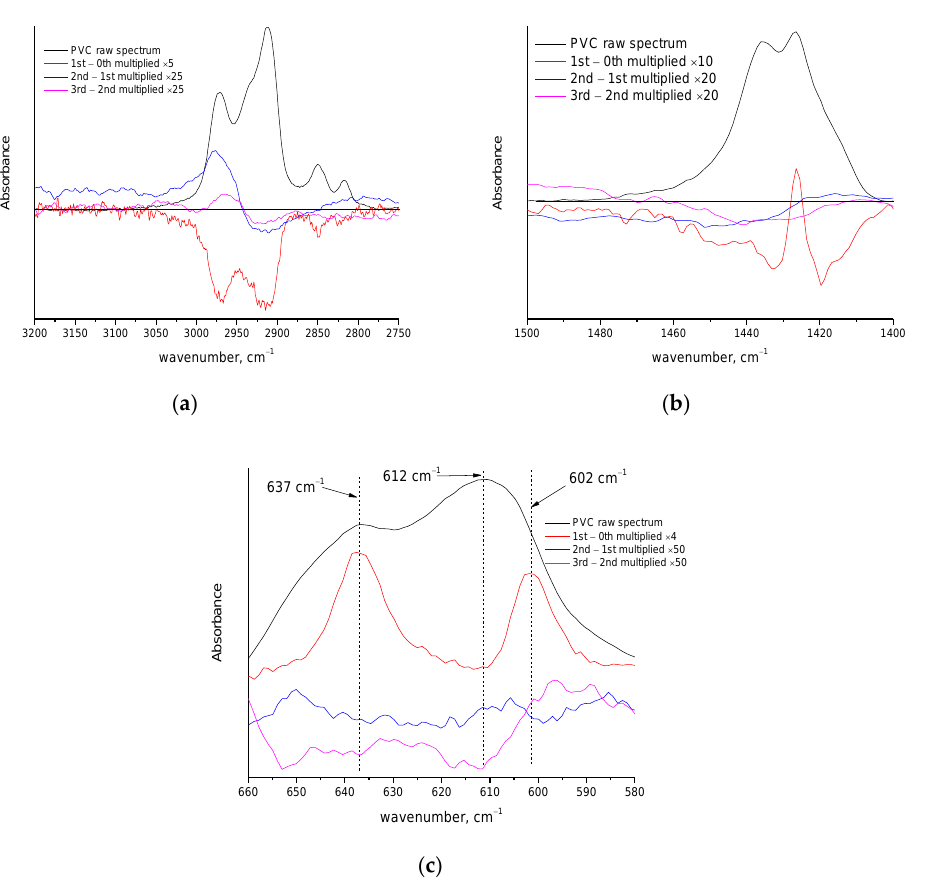
Figure 9. FTIR spectra of PVC raw material and subtracted spectra before and after three consecu- tive heating cycles at 170 °C: ( a ) in the region 3200–2750 cm −1 ; ( b ) in the region 1500–1400 cm −1 ; ( c ) in the region 660–580 cm −1